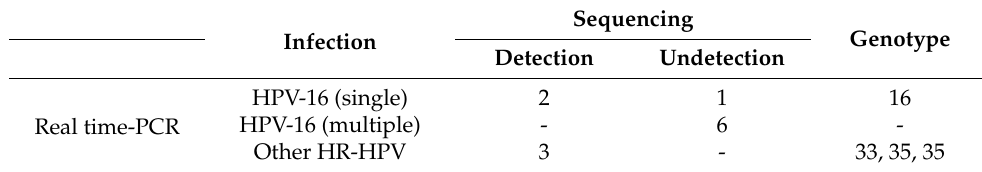
Table 2. HPV sequencing results from 12 male urine samples diagnosed by real-time PCR HPV DNA test. Infection